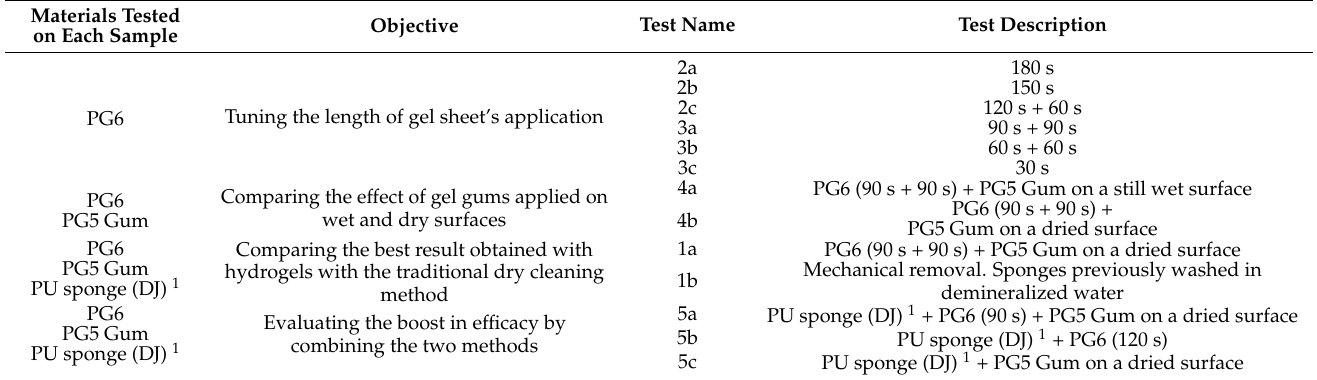
Table 2. Cleaning tests carried out on mockups. For each sample a non-soiled area has been kept as reference. Materials Tested on Each